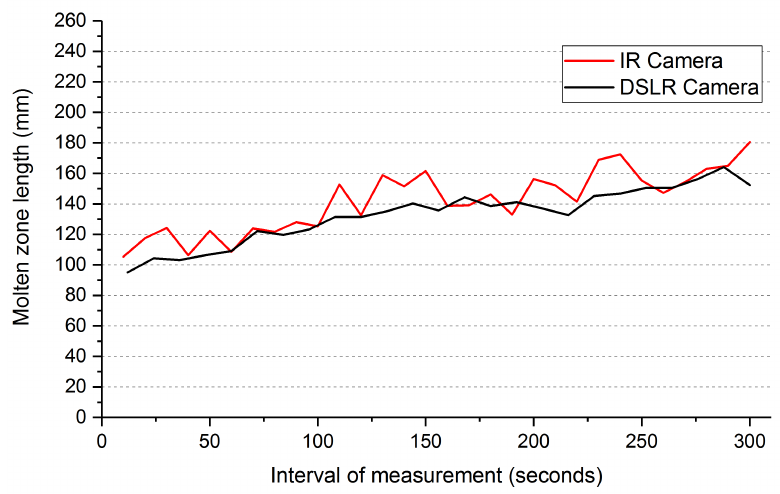
Figure 7. Values of molten zone length obtained via the IR camera and the DSLR